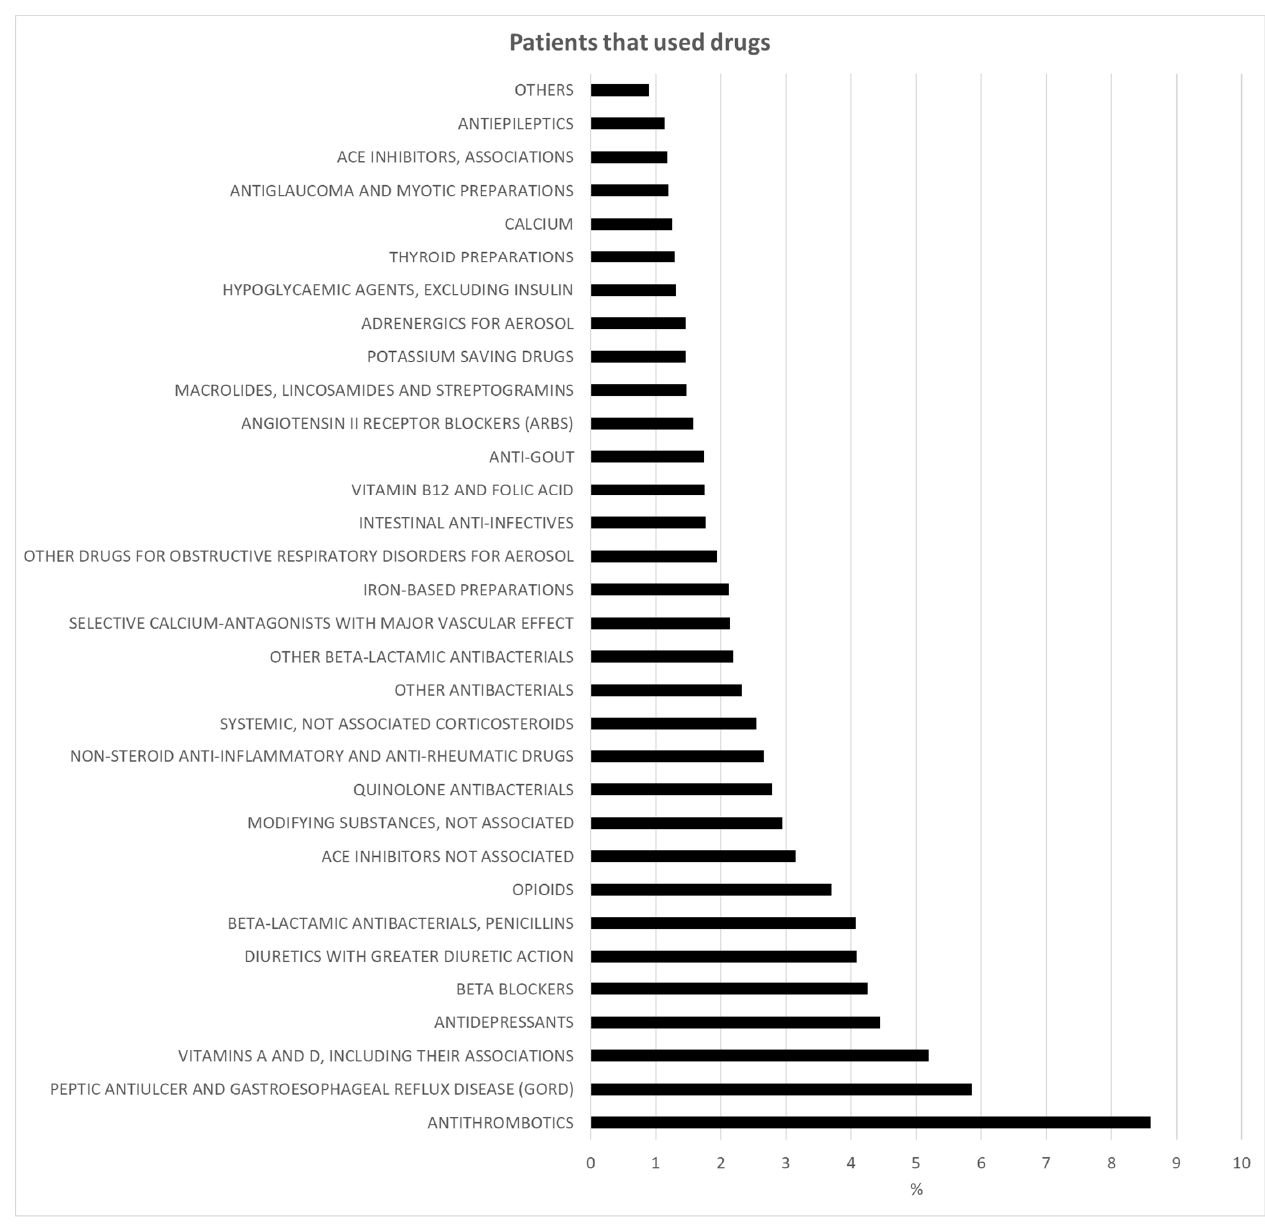
Figure 2. Percentage distribution (%) of the different drug types taken by the study population. Overall, as observed in Figure 3, the drugs used had a similar profile between pa- A weak positive correlation was assessed within the number of drugs used and the tients <85 years and patients ≥ 85 years both in males and females. number of chronic conditions (r = 0.3, p < 0.0001). In multivariable analysis, patients with ≥ 2 comorbid conditions had a statistically increased risk of polytherapy defined as taking ≥ 5 drugs, compared to patients without multimorbidity (OR = 3.0; 95%CI: 1.4–6.4, p = 0.004) (Table 3). In addition, polytherapy statistically increased LOS by more than nine days (OR = 1.8; 95%CI: 1.1–2.8, p = 0.015) (Table 3). One-year mortality after surgery was 18.5% ( n = 170). The presence of comorbid conditions was statistically associated with an increased risk of 1-year mortality (HR = 1.7; 95%CI: 1.2–2.4, p = 0.003), whereas polytherapy was statistically associated with a decreased risk of 1-year mortality (HR = 0.3; 95%CI: 0.2–0.5, p < 0.0001) (Table